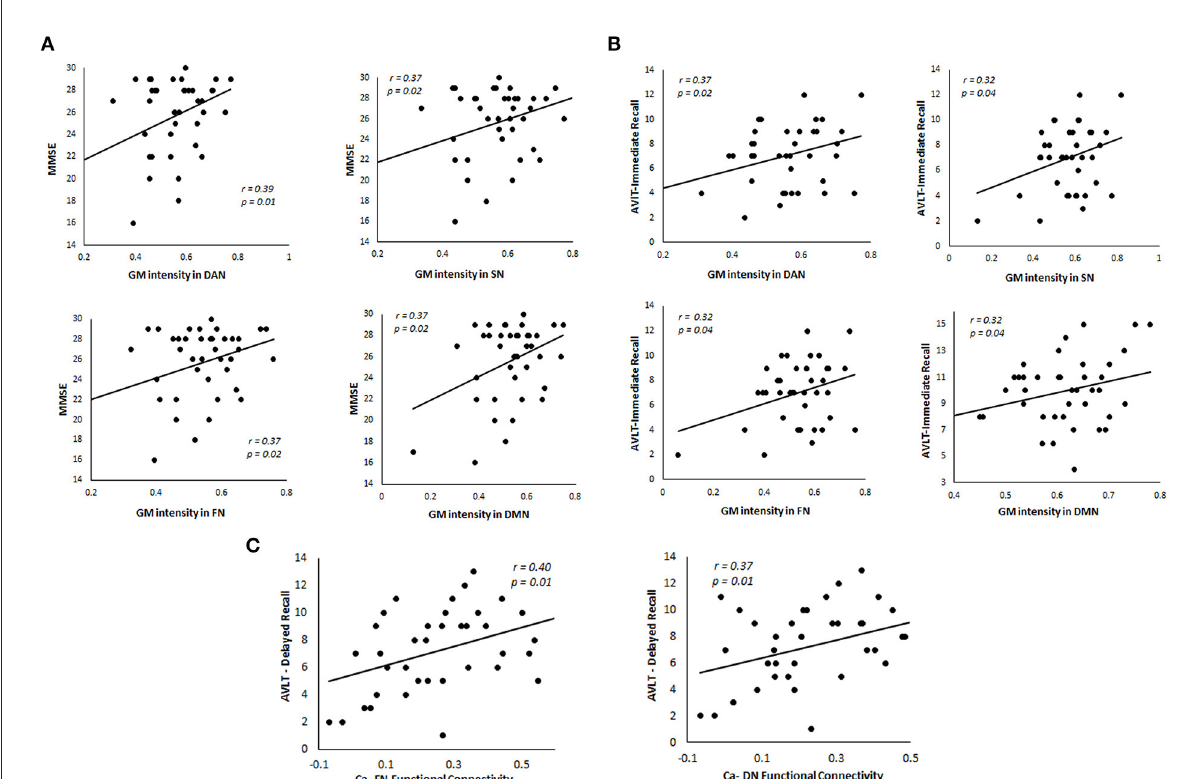
FIGURE5 Relationship between GM intensity and caudate functional connectivity in the cerebellum in svMCI patients. (A) Correlation between MMSE scores and GM intensity in four major cerebellar networks. (B) Relationship between AVLT-Immediate Recall performances and GM intensity in four major cerebellar networks. (C) Relationship between functional connectivity of caudate with cerebellar networks and AVLT-Delayed Recall performances in svMCI patients. FN, Ventral Network; DAN, Dorsal Attention Network; SN, Somatomotor Network; DMN, Default Mode Network; Ca,